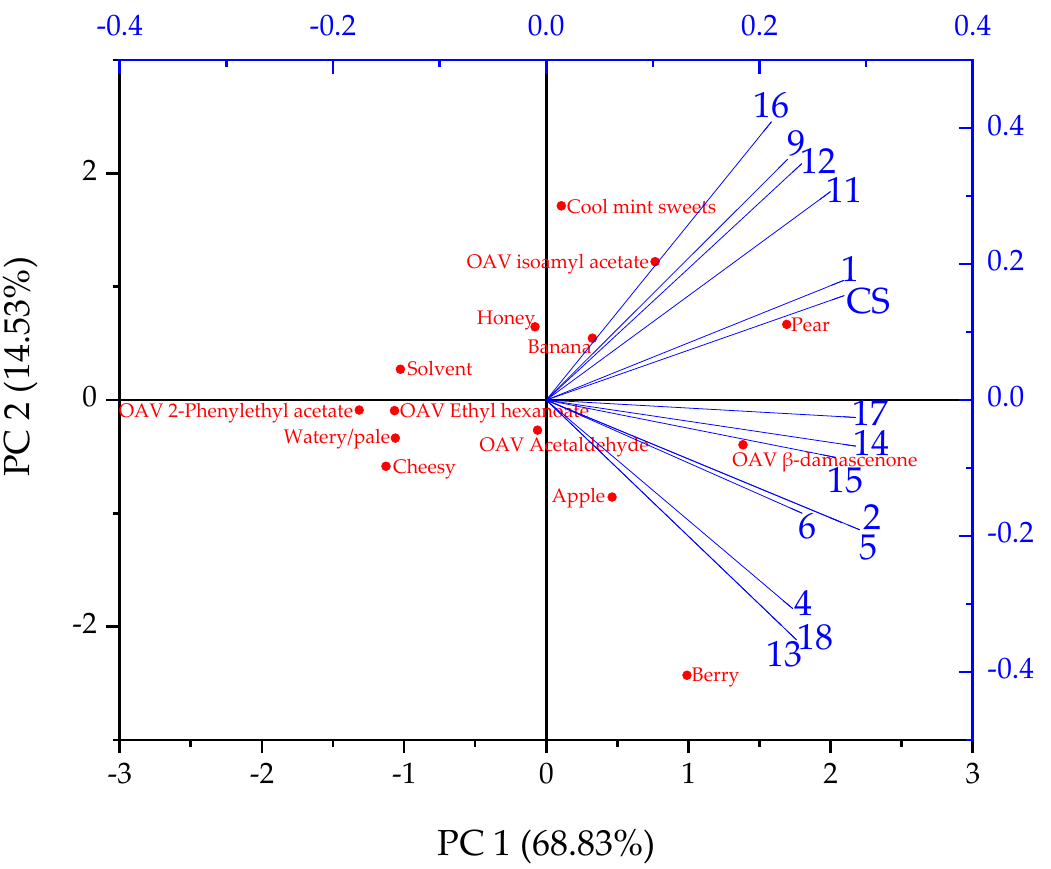
Figure 5. Principal Component Analysis (PCA) biplot with two principal components PC 1 and PC 2 showing the correlation of the 15 beers produced with the yeast strain C. saturnus TUM 247 as loading plot and the flavor characteristics described by the sensory assessors as well as odor activity values (OAV) of ( E )- β -damascenone, isoamyl acetate, ethyl hexanoate, 2-phenylethyl acetate, and acetaldehyde.